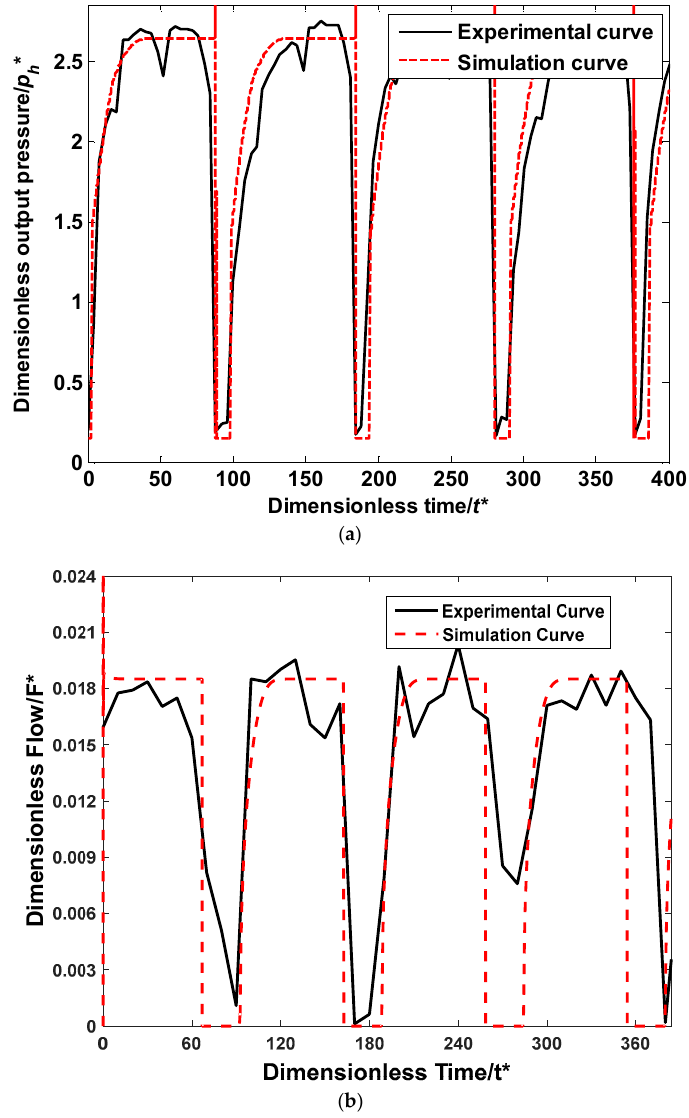
Figure 5. Simulation and experimental contrast curves. ( a ) Simulation and experimental curves of the dimensionless output hydraulic pressure; ( b ) Simulation and experimental curves of the dimensionless